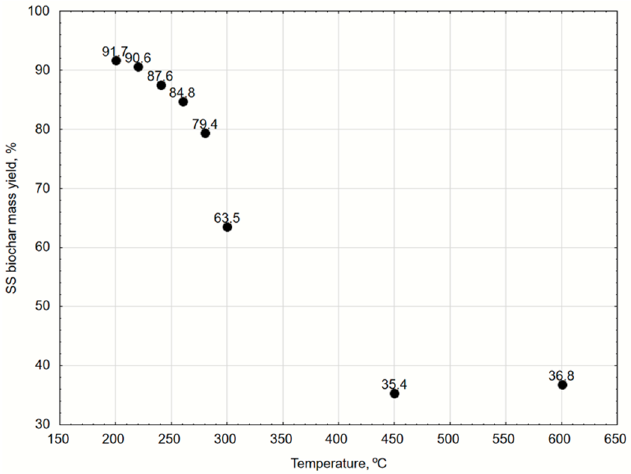
Figure 2. The mass yield of the biochar produced under different torrefaction/pyrolysis temperatures.